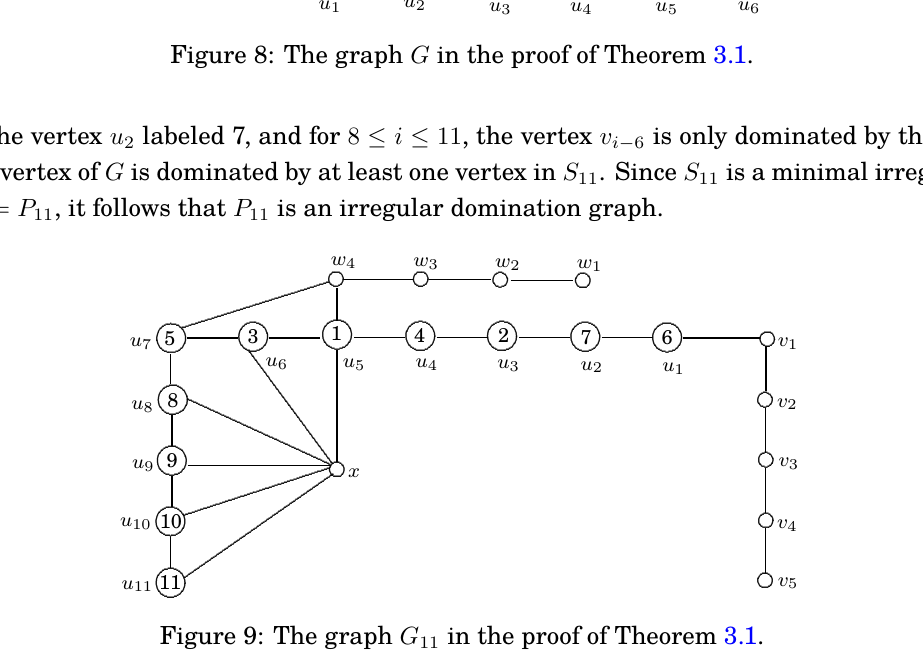
in the proof of Theorem 11